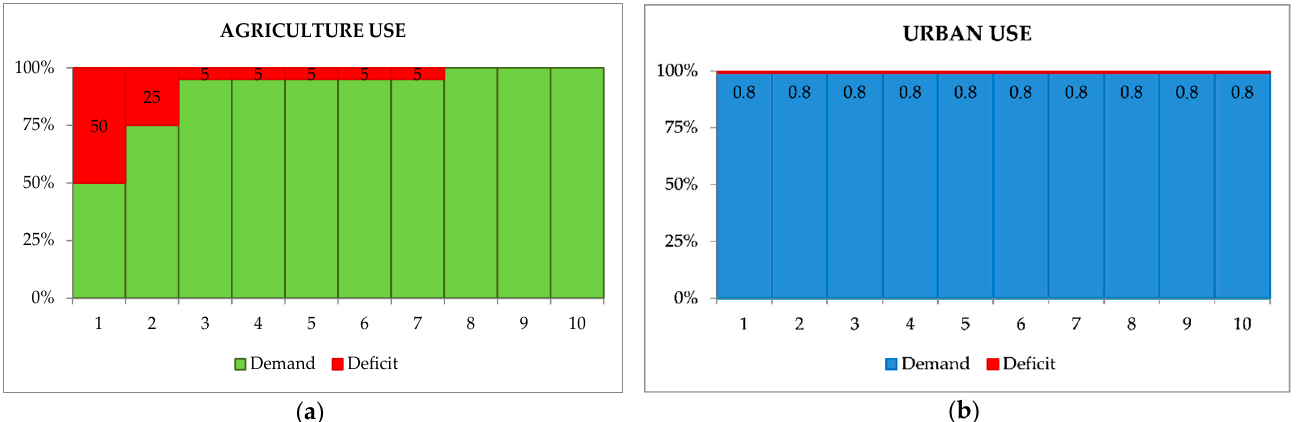
Figure 5. ( a ) Guarantee criteria agricultural use; ( b ) guarantee criteria urban use. Source: own elaboration based on [62].